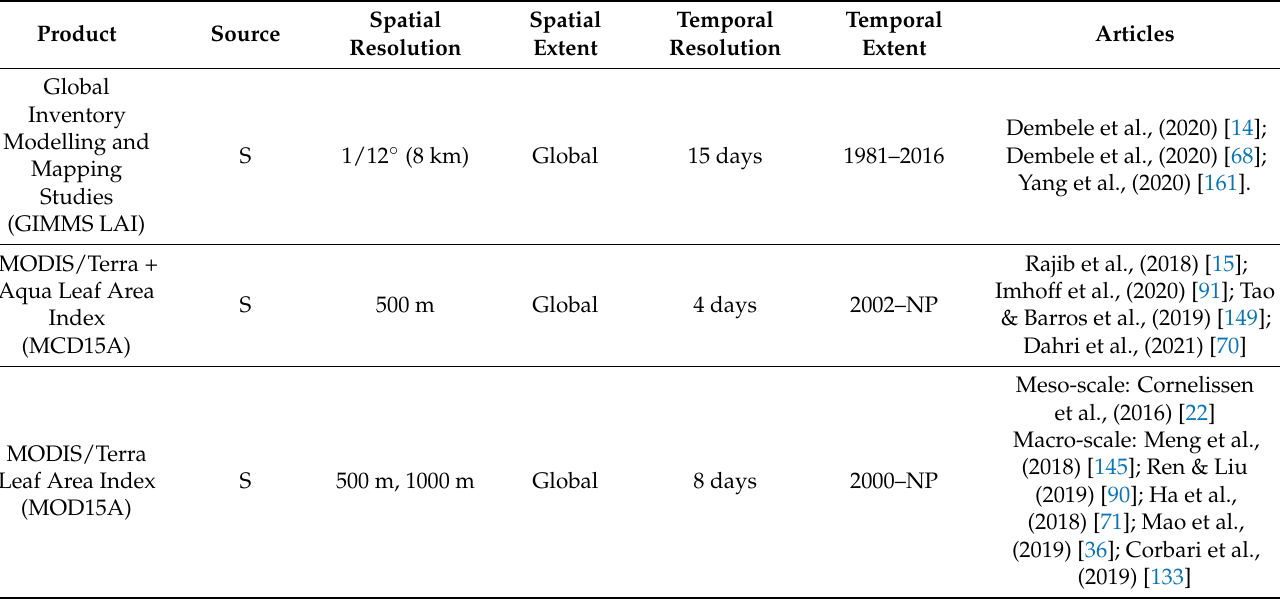
Table A5. Leaf area index (LAI) products used in reviewed